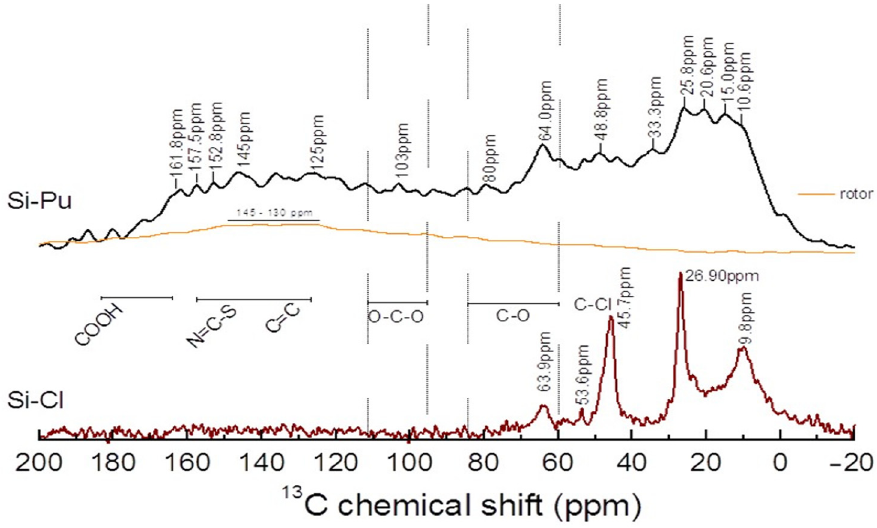
Figure 6. 13 C ‐ NMR spectra of the materials Si ‐ Cl and Si ‐ Pu. Figure 6. 13 C-NMR spectra of the materials Si-Cl and